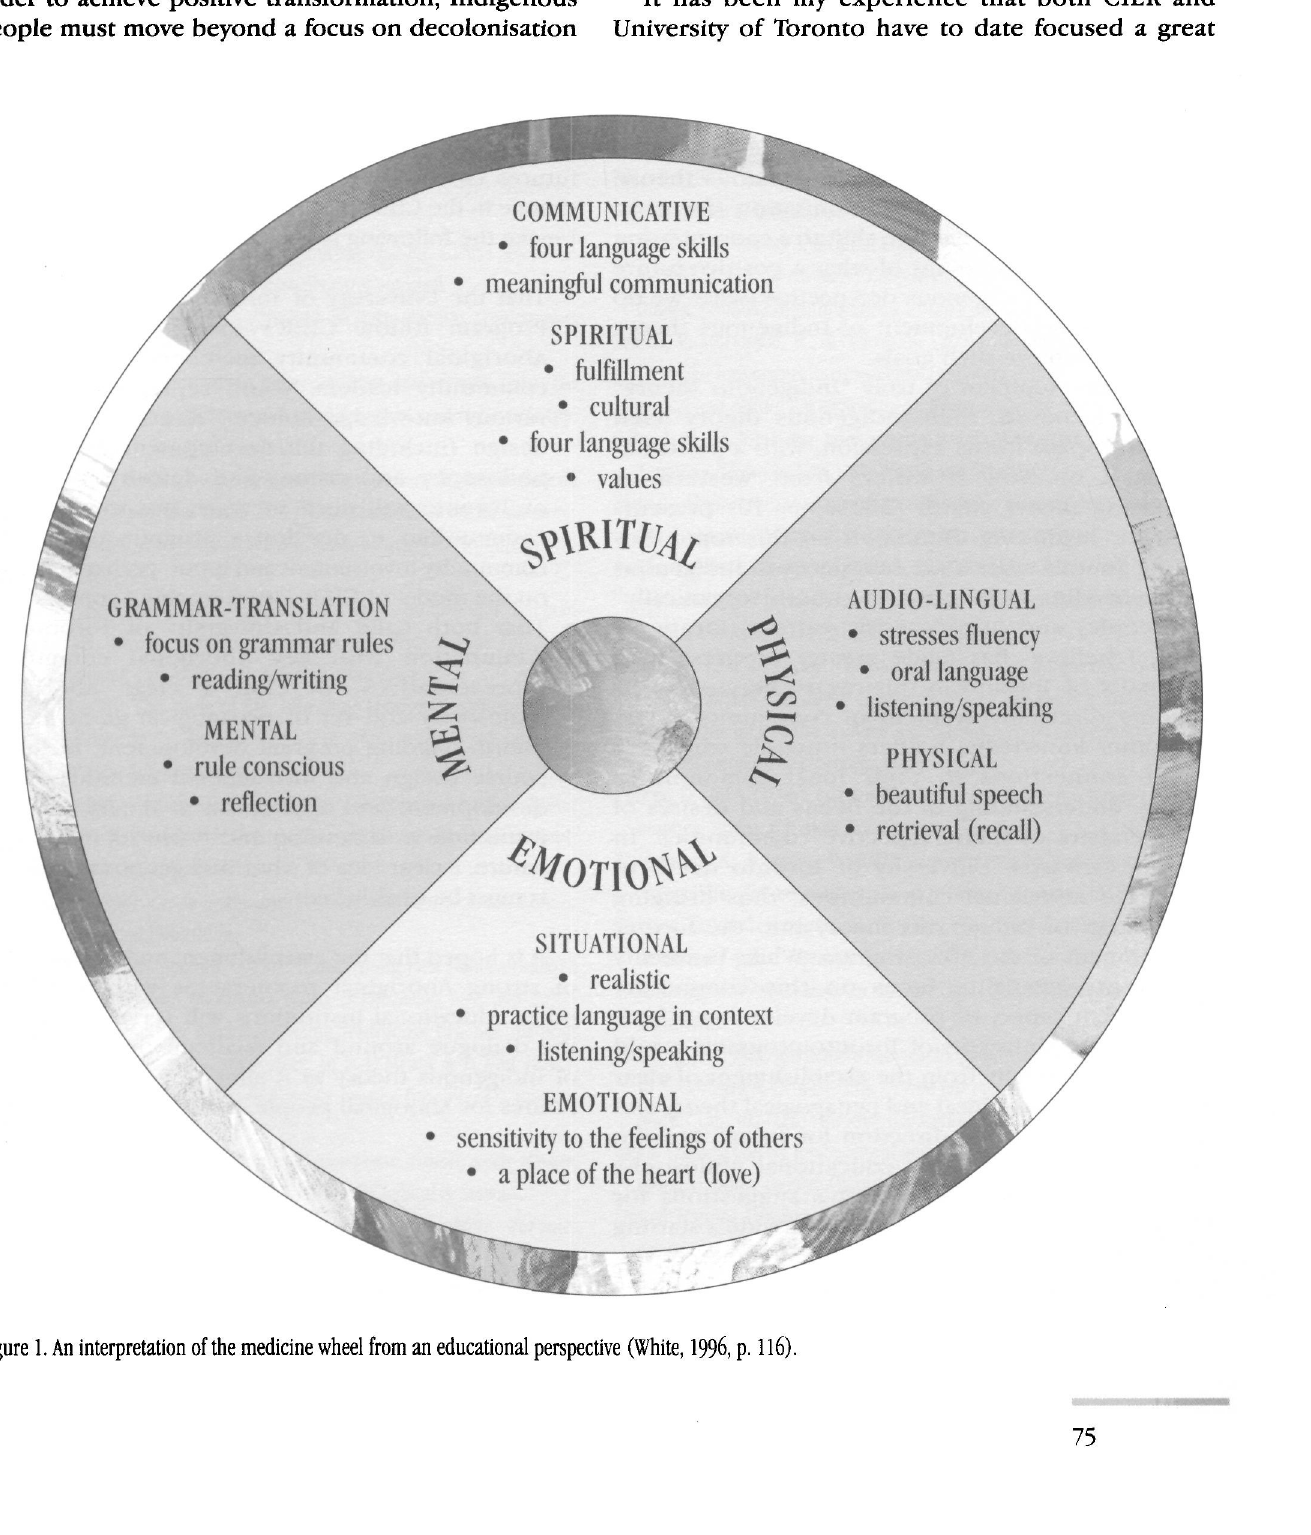
Figure 1. An interpretation of the medicine wheel from an educational perspective (White, 1996, p.